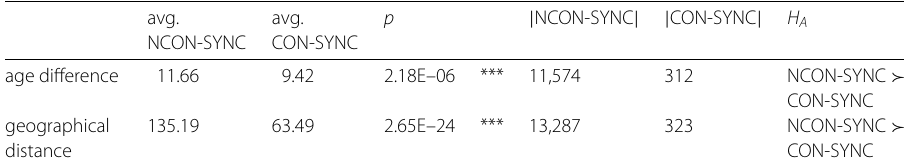
Table 5 One-sided Welch’s t -test on the differences in age and geographical distance between NCON-SYNC and CON-SYNC sets. Trade synchronization between investors is validated at the significance level of α = 0.01. Here, H A is the direction of the alternative hypothesis. The units for the co-insidership are trading days, age difference in years, and geographical distance in kilometers